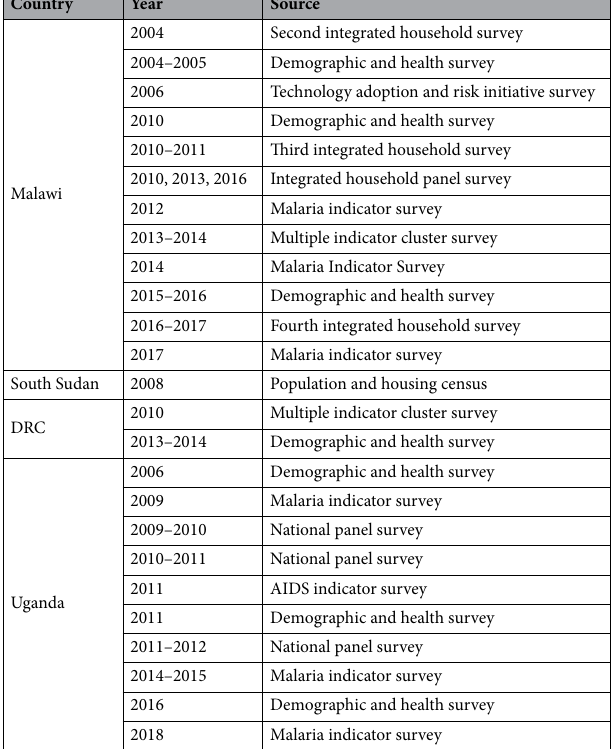
Table 1. Data sources by